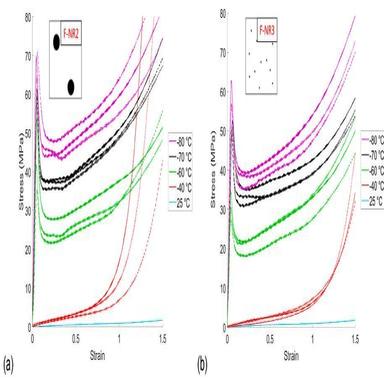
Low rate, varying temperature results for the 5% filled composites: (a) F-NR2 and (b) F-NR3.